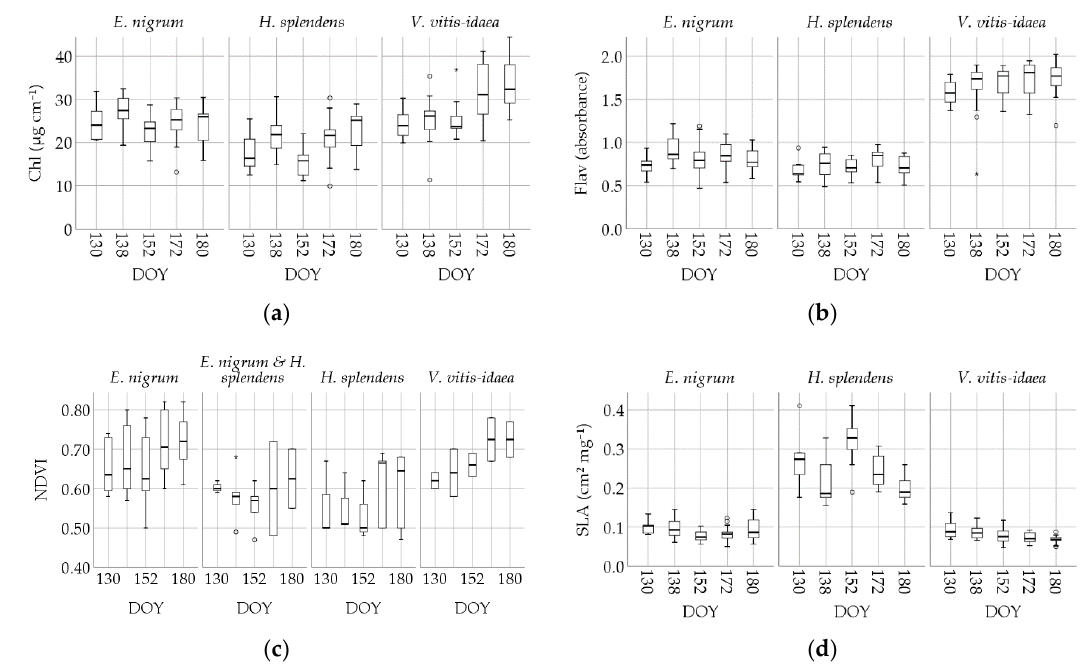
Figure 3. Intraspecific trait variability and its changes during the spring season for the species Empterum nigrum , Vaccinium vitis-idaea, and Hylocomium splendens . All species were monitored in varying health states, while each value represents one plot dominated by the named species. ( a ) Chlorophyll content (Chl); ( b ) flavonols (Flav); relative absorbance values; ( c ) Greenseeker NDVI; ( d ) SLA. These results were obtained at a moisture content (percent of wet weight) ranging from 55% to 75% for H. splendens, 63 to 68% for V. vitis-idaea, and 63 to 71% for E. nigrum.